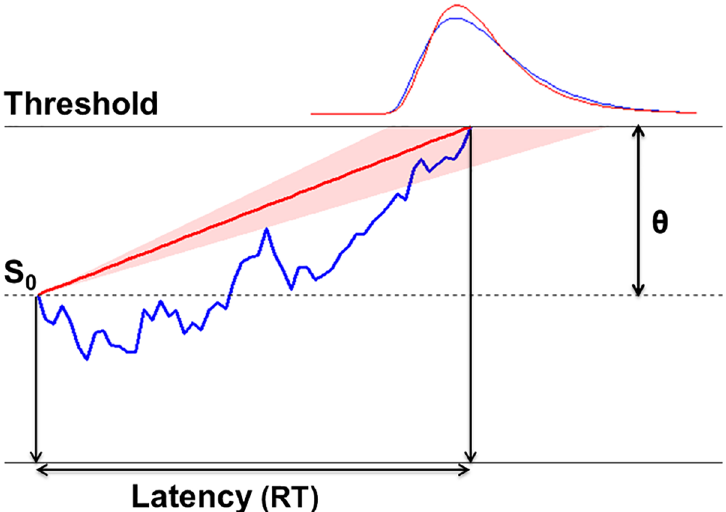
Fig 1. Illustrations of the drift diffusion model (DDM, shown in blue) and the LATER model (shown in red). The DDM assumes that evidence accumulates, from the starting point ( S 0 ), through random diffusion in combination with a drift rate r until a boundary (i.e., threshold, θ ) is reached. The LATER model makes the same assumptions, except that the rate r is considered to be constant within any individual trial, but to vary across trials (so as to explain trial-to- trial variability in